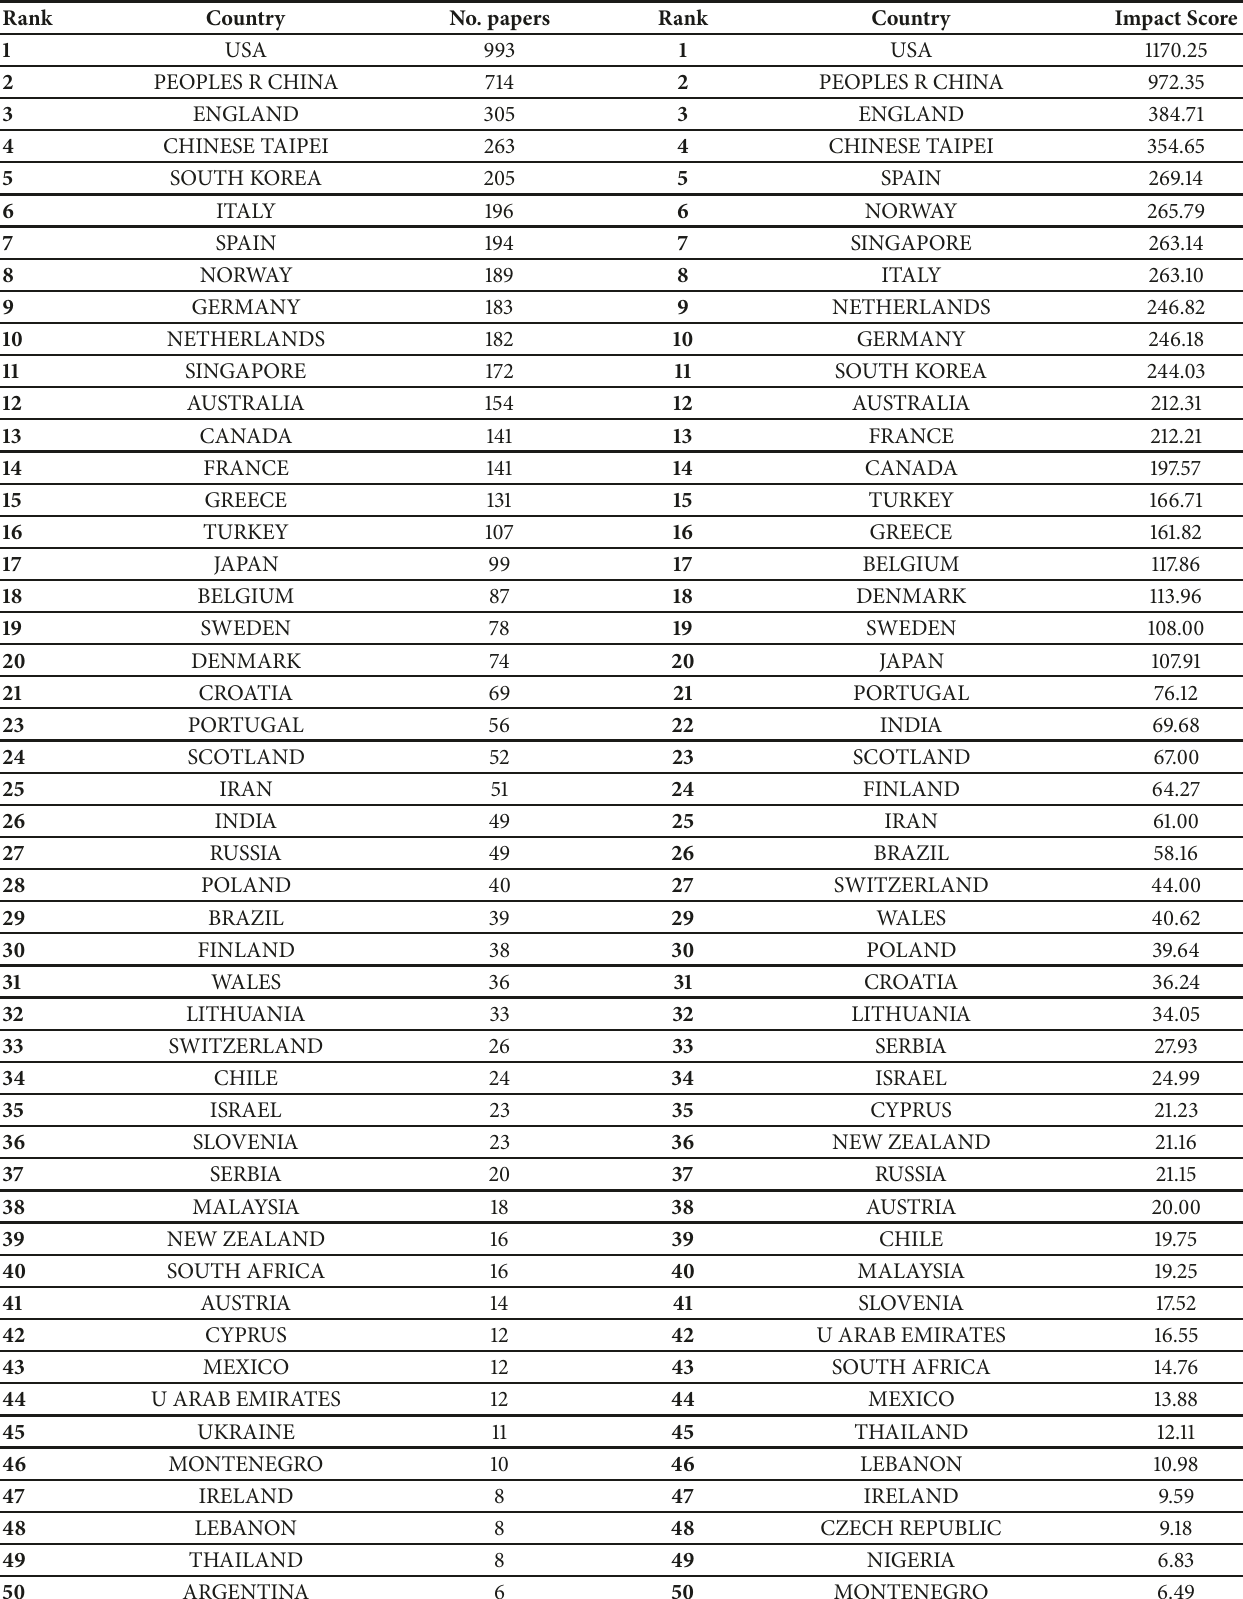
Table 9: The ranking of the